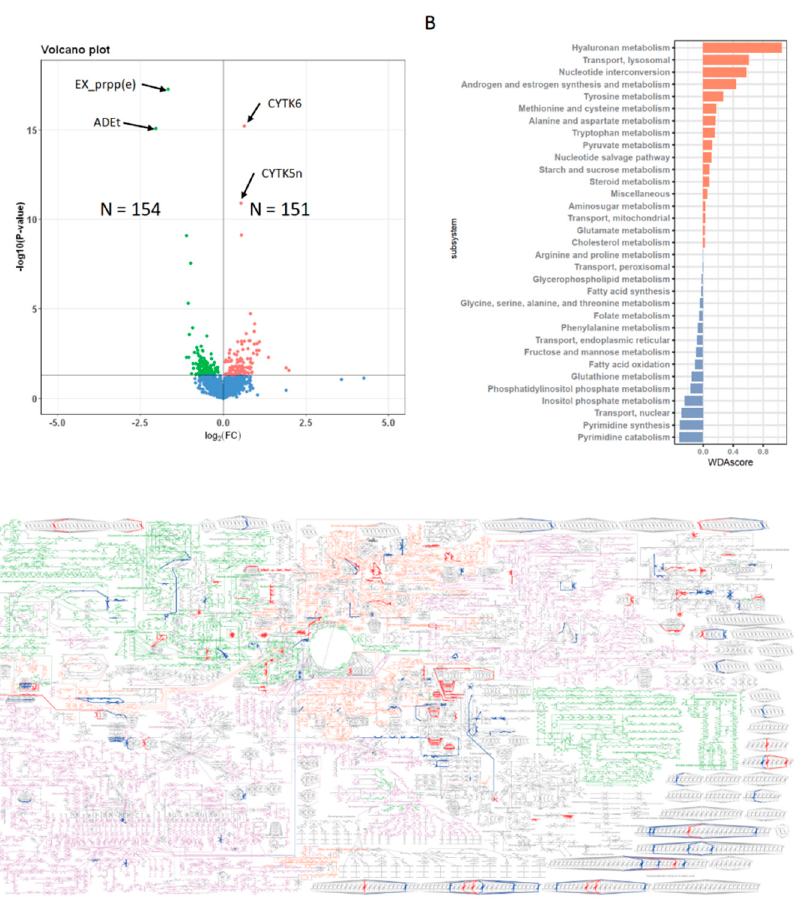
Figure 3. Metabolic profiles of N + P − . ( A ): Volcano plot of differential reactions between the N + P − and N − P + . Up- and down-regulated reactions in N + P − are colored red and green, respectively. ( B ): Differential metabolic pathways between the N + P − and N − P + . ( C ): Overall metabolic changes in N + P − . The overall metabolic map of Recon was downloaded from the Virtual Metabolic Human Database (https://vmh.uni.lu/). Three general metabolic pathways, including carbohydrate metabolism, amino acid metabolism, and fatty acid metabolism, are colored green, orange, and purple, respectively. The significantly up- and down-regulated reactions in N + P − are colored bold red and bold blue, respectively.